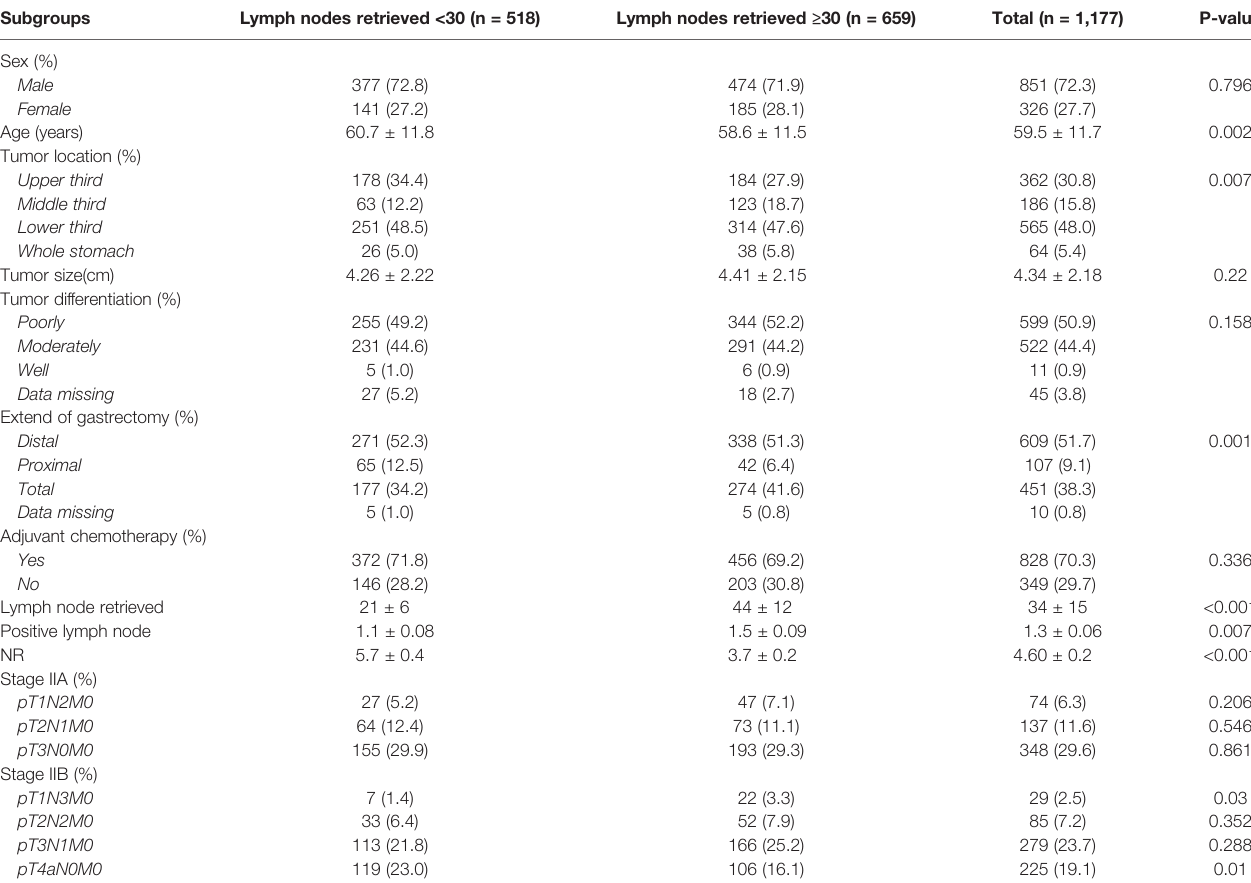
TABLE 1 | Patient characteristics and P value of univariate